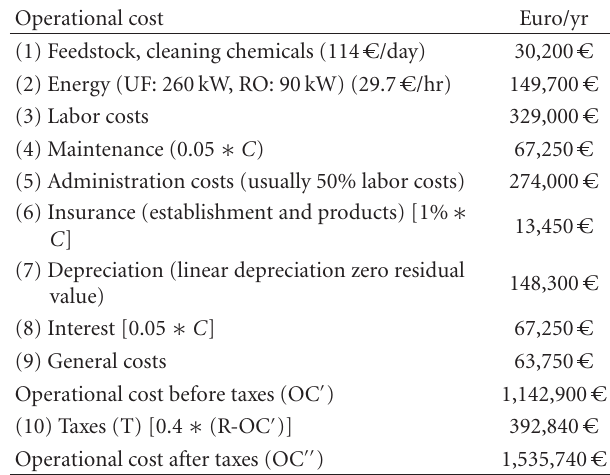
Table 3: Operational costs for an OMW treatment unit of 50,000 t/yr